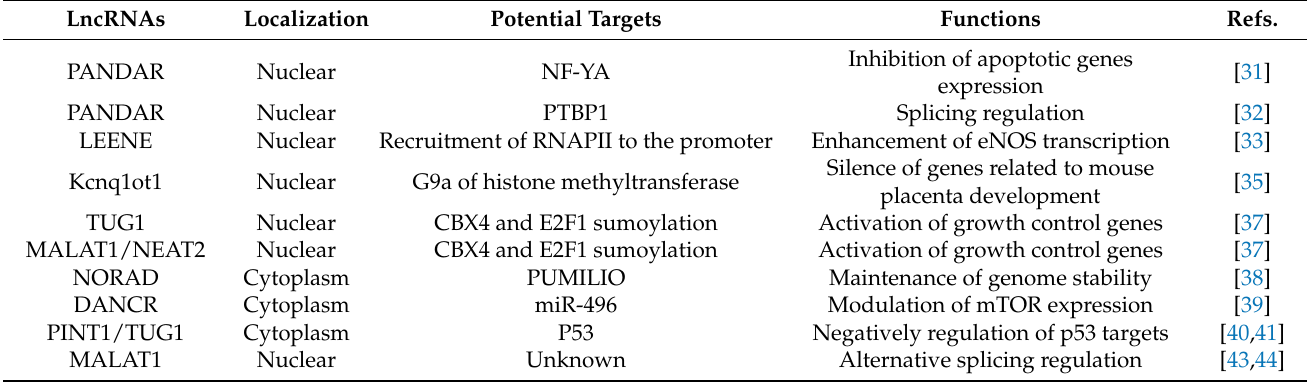
Table 2. LncRNA functions in transcription